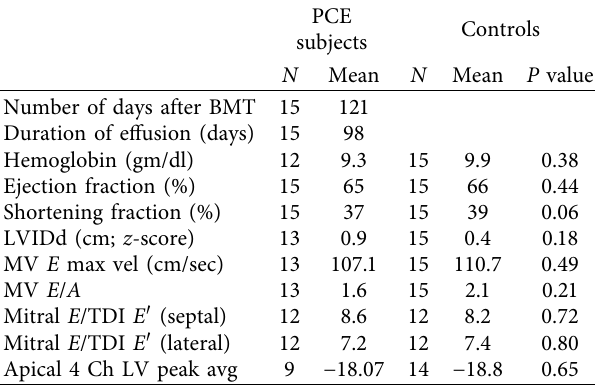
Table 3: Pretransplant comparison of cardiac markers.